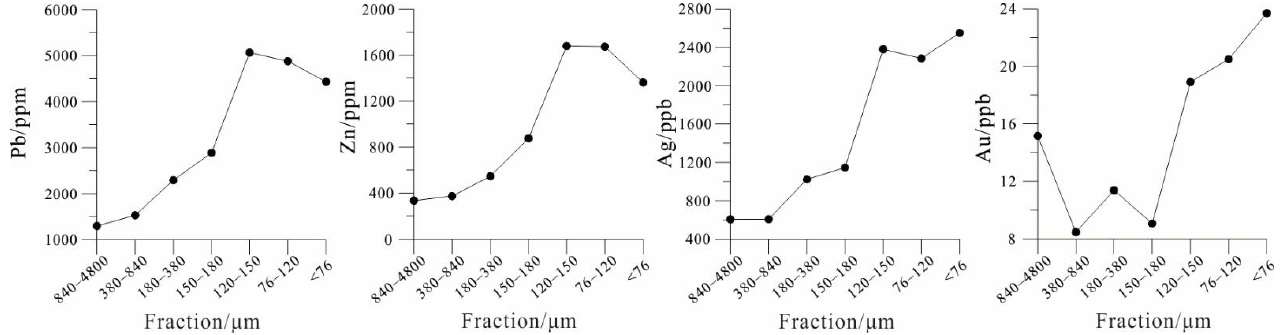
Figure 5. Pb, Zn, Ag, and Au line chart in different sized soil fractions in the Huaniushan test area. The line chart of Pb and Zn in the fine fraction of soil (<76 μm) across the concealed mineralized zone (the survey line is marked with a blue line in Figure 2) is shown in Figure